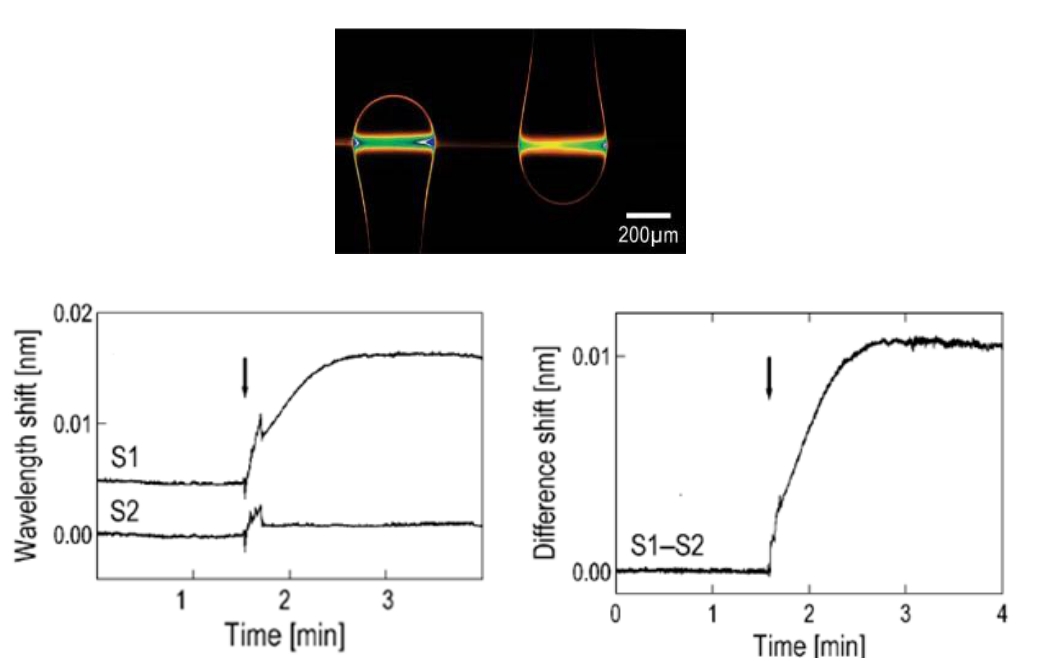
Figure 11. Top: Optical image of two microspheres coupled to a taper, showing two resonances orbiting inside the spheres. Bottom: Single nucleotide mismatch detection; left: time traces of the two microspheres, the perfect match sequence gives a signal 10 times larger; right: difference signal, allowing to achieve SNR = 54. Reprinted with permission from [47] © 2003,